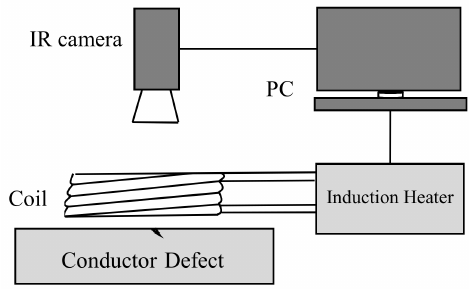
Figure 1. Schematic diagram of